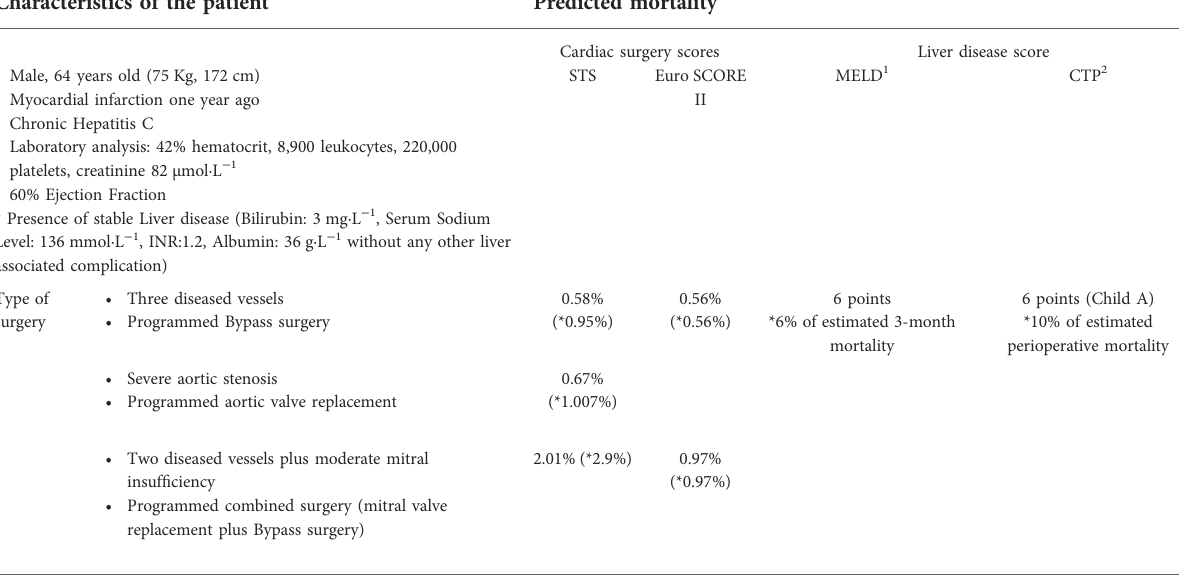
TABLE 3 Example of predicted mortality with main cardiac surgery scores compared with liver scores in patients without and with liver disease. Characteristics of the patient